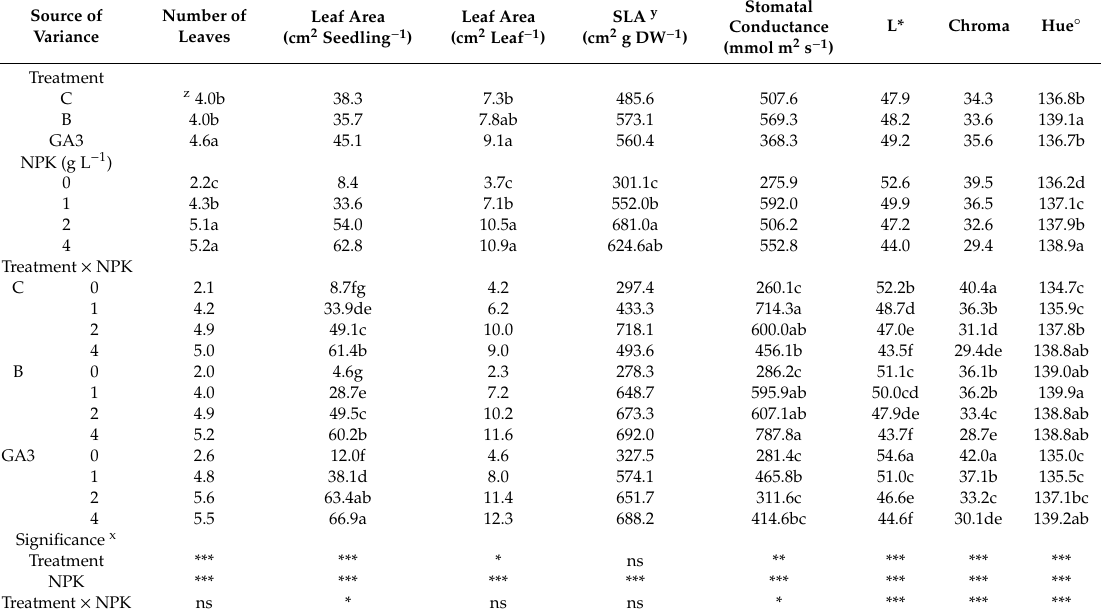
Table 2. E ff ects of the seedling treatments (C, untreated control, B, bacterial biostimulant, GA3, gibberellic acid spray 10 − 5 M) and the nursery fertigation rates (g L − 1 of NPK 20-20-20) on the leaf characteristics of Solanum lycopersicum ‘Marmande’ seedlings.